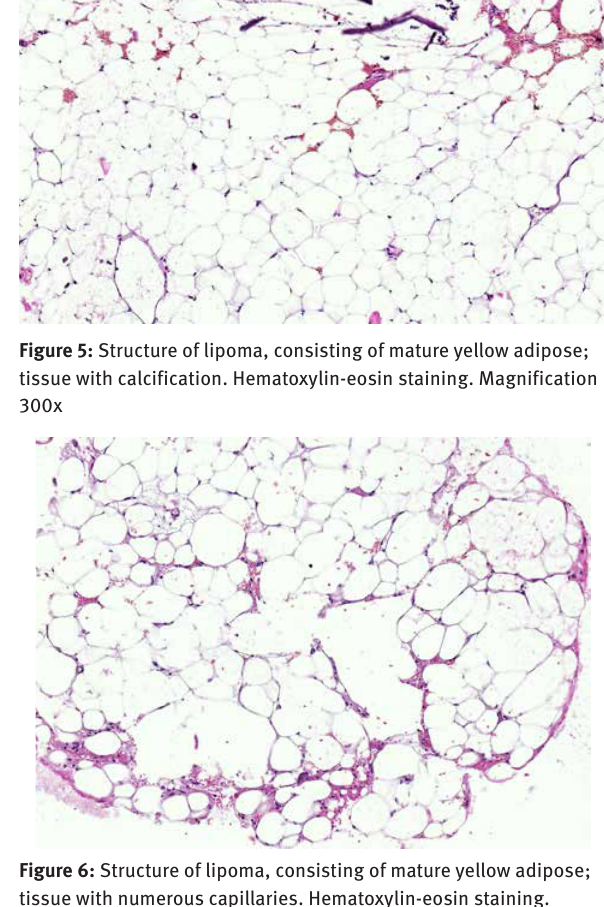
Figure 4: Patient A.R., age 32. Tumour enucleated from body of mandible in region of teeth 41 – 44.